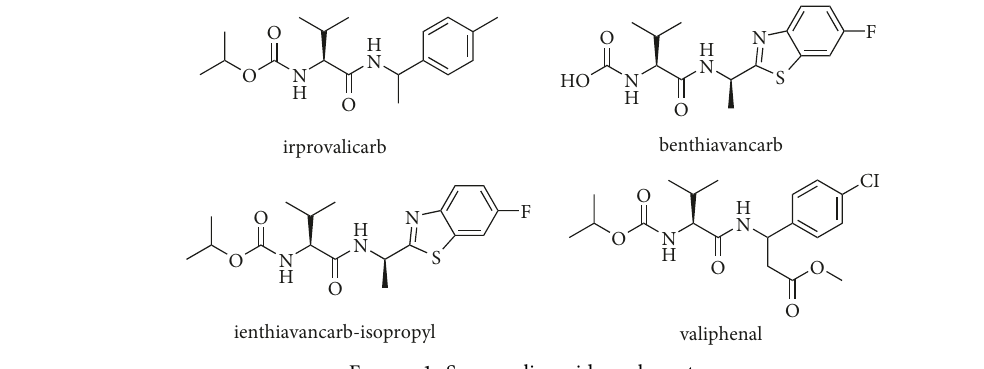
Figure 1: Some valinamide carbamates.